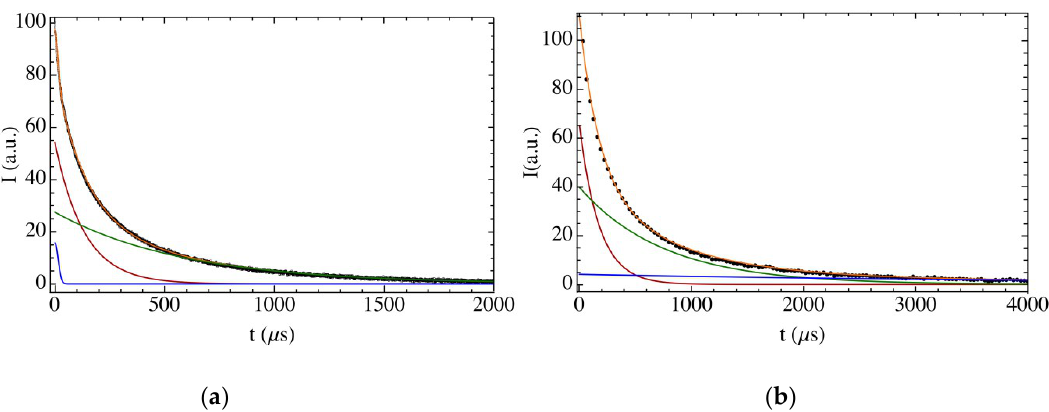
Figure 4. ( a ) Fitting of the on-resonance 1 H Free Induction Decay (FID) (dotted line) recorded by Solid Echo (SE) pulse sequence for the sample V-NS-SilSepS9/SBR. The fitting function (orange line) and the single contributions of the Gaussian (blue line), short-T 2 (red line), and long-T 2 (green line) exponential components are shown. ( b ) Fitting of the Carr-Purcell-Meiboom-Gill (CPMG) relaxation curve (dotted line) recorded for the sample, V-NS-SilSepS9/SBR. The fitting function (orange line) and the single contributions of the three exponential components, exp1 (red line), exp2 (green line), and exp3 (blue line), are shown.